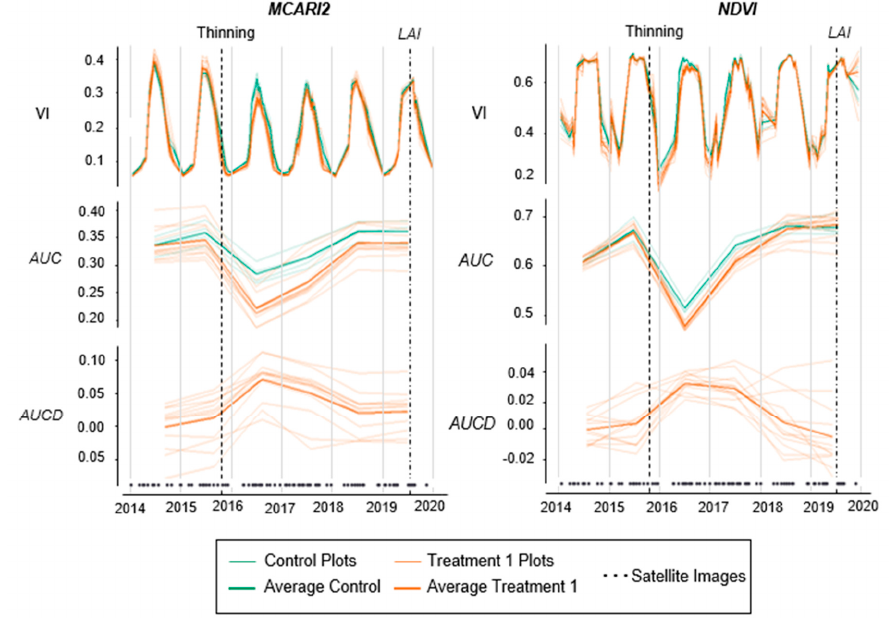
Figure 6. Evolution of the values for MCARI2 and NDVI with all of the valid L8 images available between 2014 and 2019 Trial 2. Areas under the annual VI curves ( AUC ) and differences in AUC between control and treatment plots ( AUCD ) for the same time series. Thinning refers to when the treatments were conducted and LAI refers to to when fieldwork was carried out.